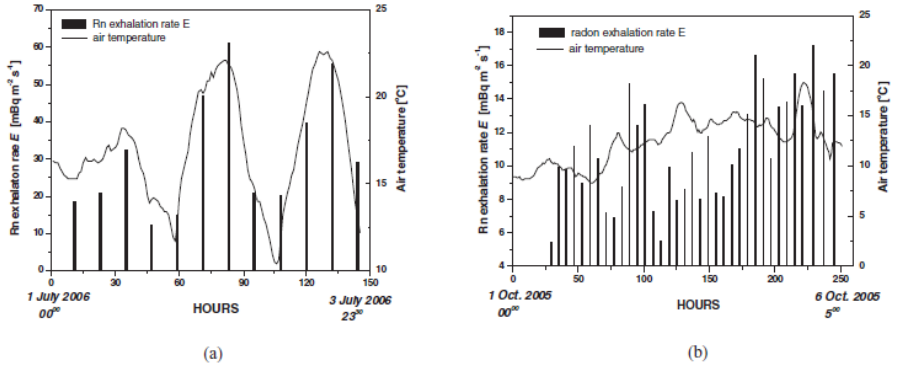
Figure 2. Variability of Rn flux with air temperature indicating. ( a ) Observe regular changes with air temperature, ( b ) not observing regular changes with temperature (Taken from [133]) .